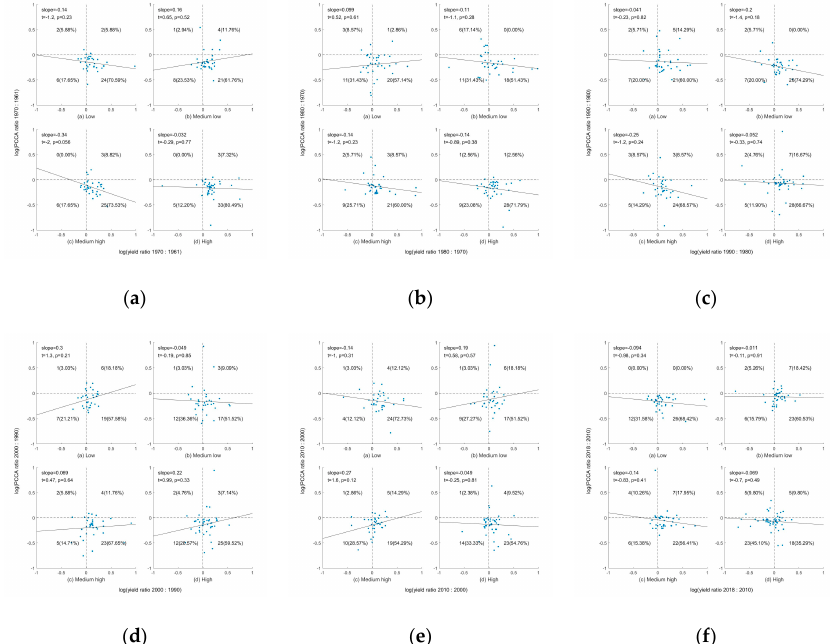
Figure 7. For classified countries, the relationship between the PCCA change and the yield change at the country scale during different time periods: ( a ) 1961–1970; ( b ) 1970–1980; ( c ) 1980–1990; ( d ) 1990–2000; ( e ) 2000–2010; and ( f ) 2010–2018. Solid lines are best-fit lines of least squares linear regression models. Graphs are divided into four quadrants by dashed lines. The percentages of countries located in the bottom right quarter during different pe-